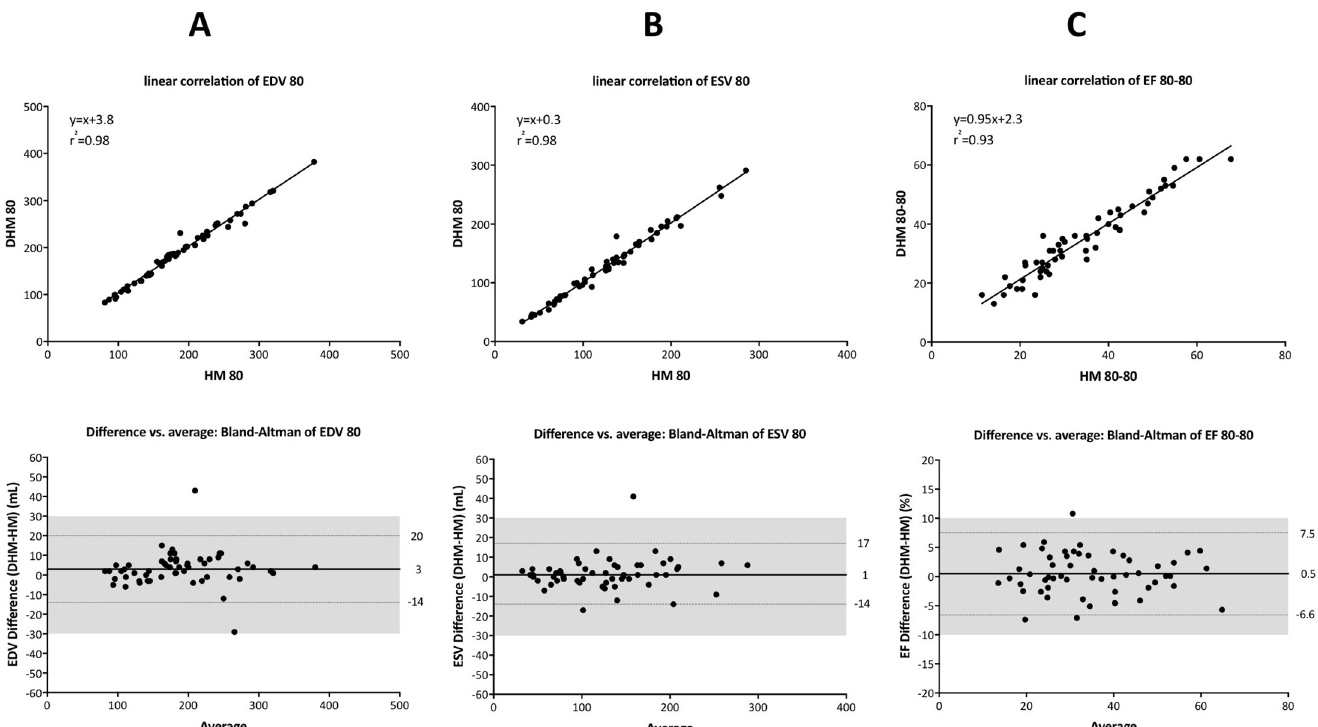
Fig 8. A linear correlation (upper panels) and Bland-Altman analysis (lower panels) of left ventricular end-diastolic volume (A), left ventricular end-systolic volume (B), and left ventricular ejection fraction (C) between Dynamic HeartModel and HeartModel with use of a border threshold value of 80 at both end- diastole and